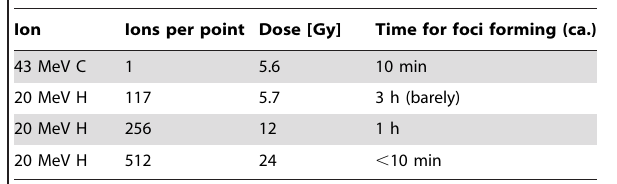
Table 3. Rad52 kinetics. Ion Ions per point Dose [Gy] Time for foci forming (ca.)